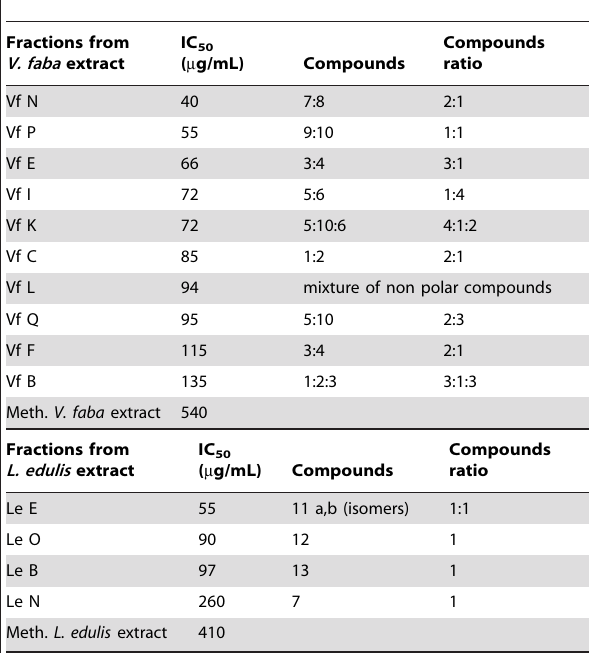
Table 1. IC 50 values and composition of the polyphenolic fractions isolated from the methanolic extracts of aerial plant parts of V. faba and L. edulis